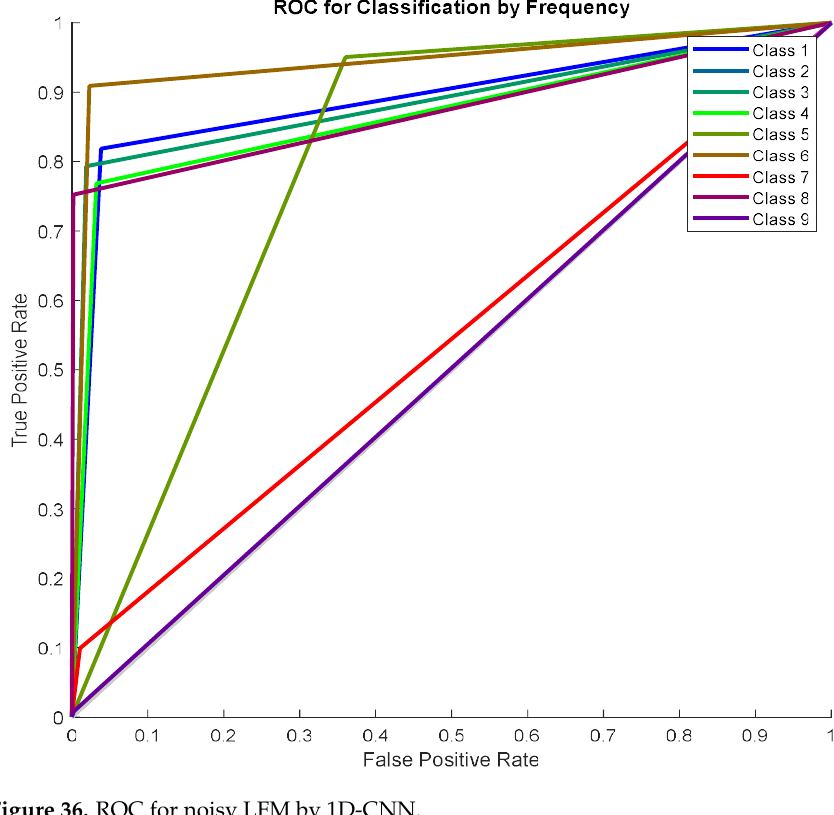
Figure 36. ROC for noisy LFM by 1D-CNN.